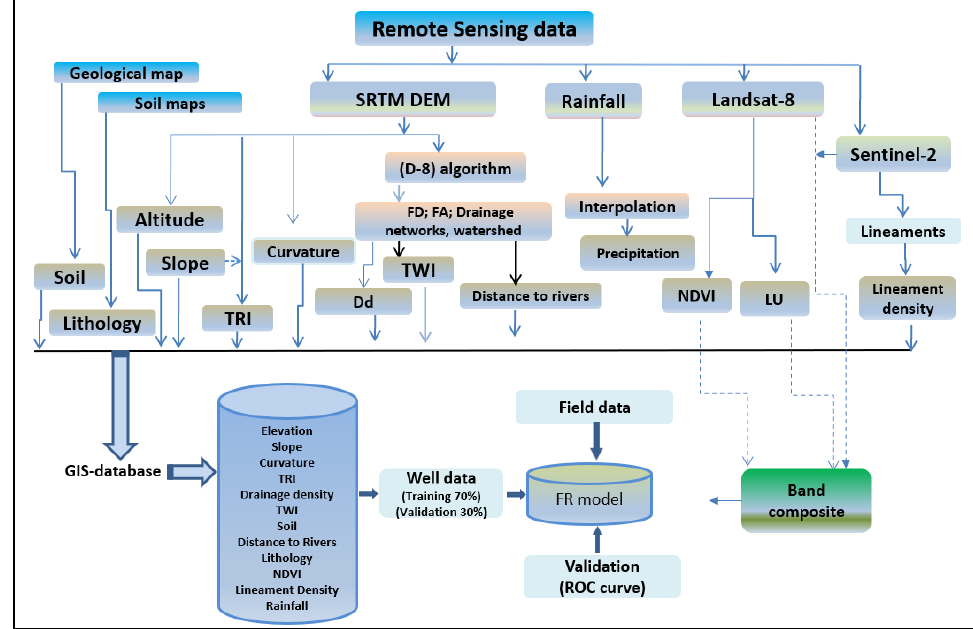
Figure 2. Diagram showing data and methods used in this study.